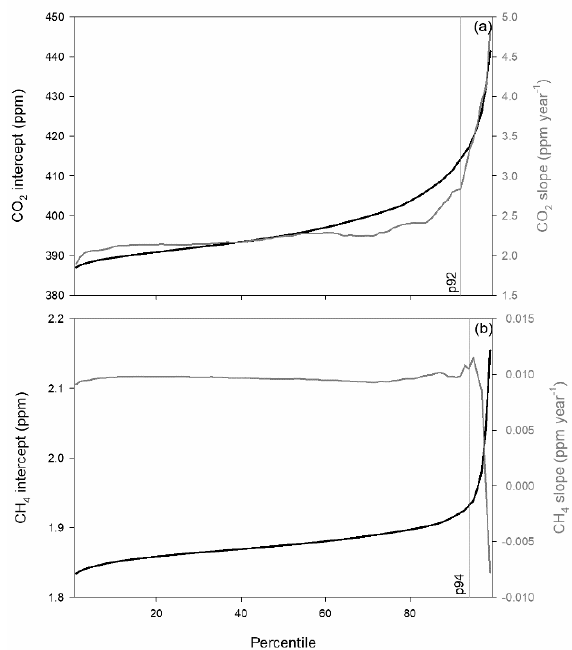
Figure 5. Parameters of the linear fit of monthly percentiles. Vertical lines indicate that correlations below these percentiles are statistically significant at a 0.001 level. ( a ) CO 2 , ( b ) CH 4 .